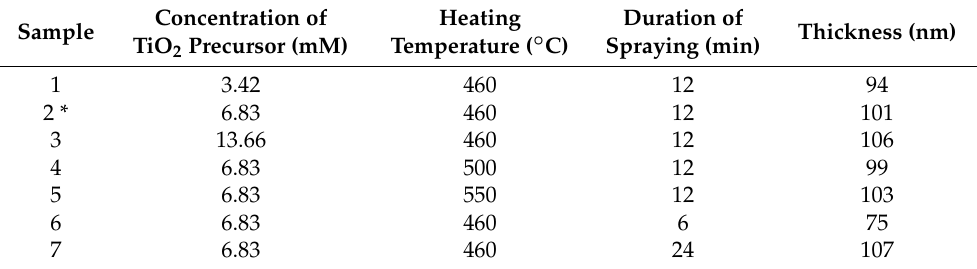
Table 1. Thickness of the TiO 2 layers on stainless steels prepared by Spray-ILGAR method by using different concentrations of TiO 2 precursor, different heating temperatures and different spraying durations.